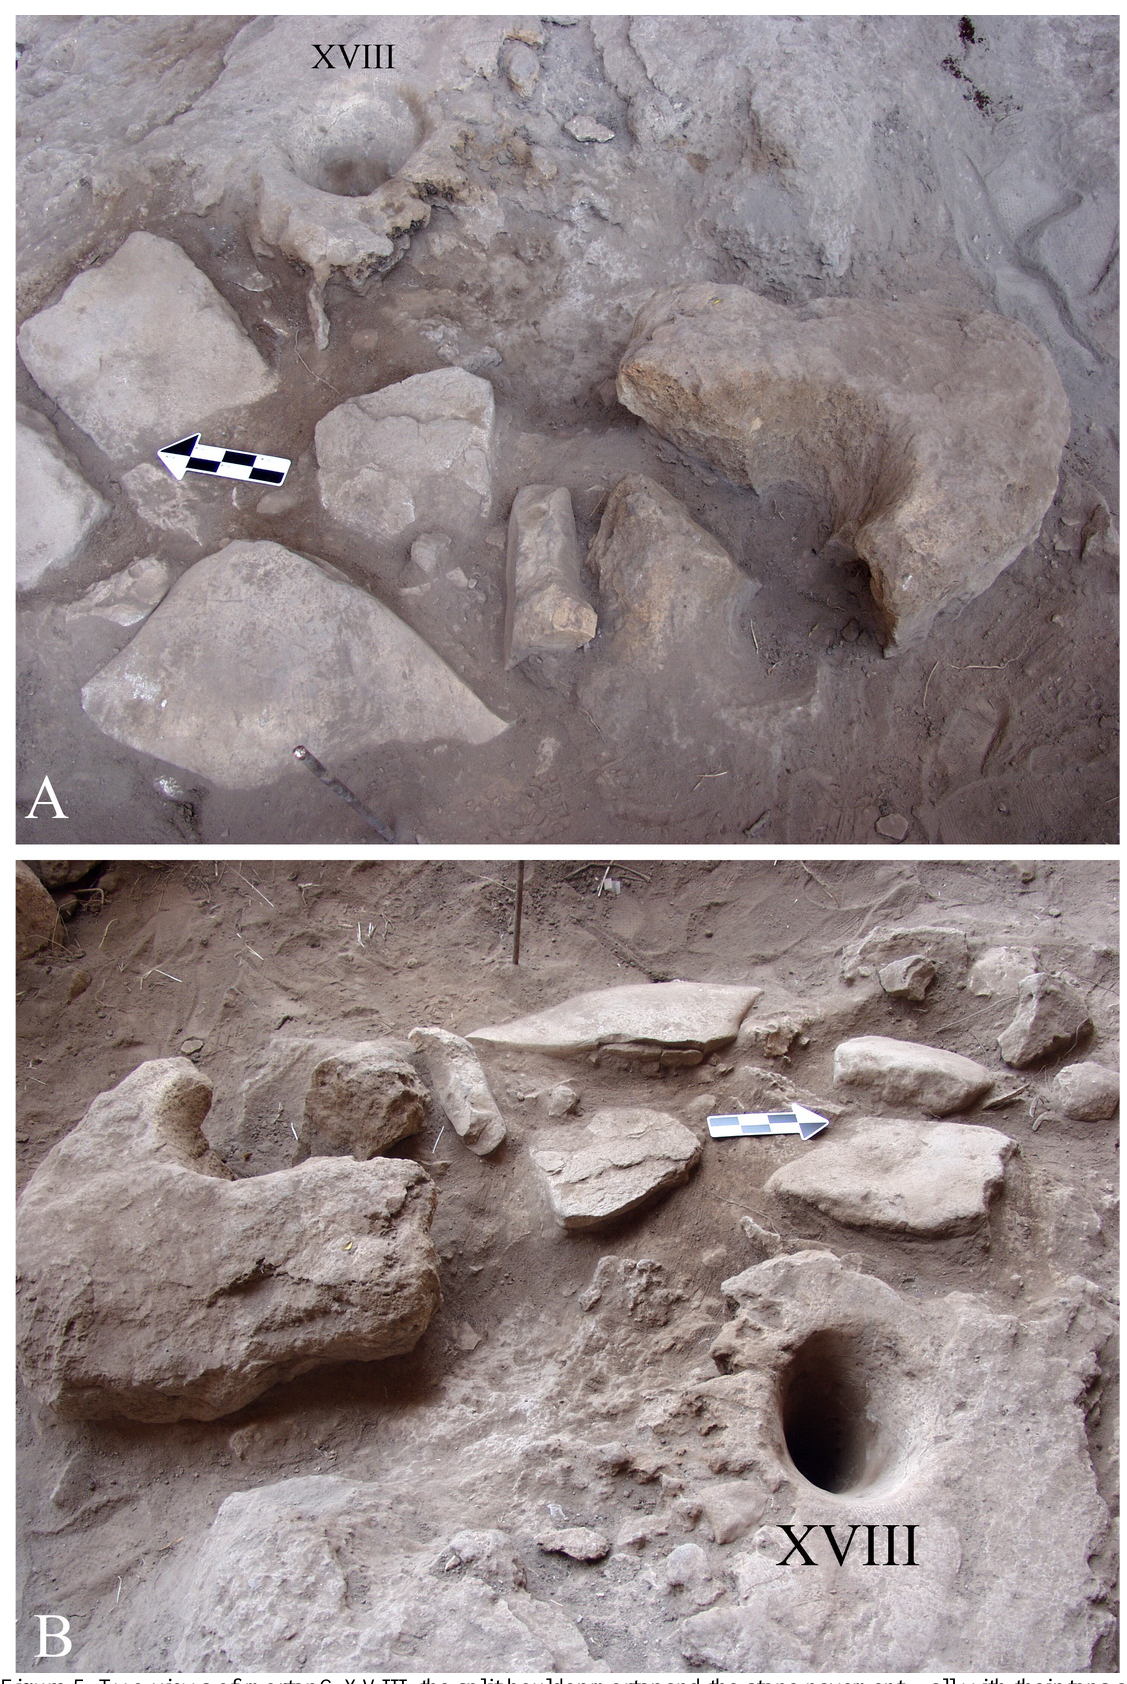
Figure 5. Two views of mortar C-XVIII, the split boulder mortar and the stone pavement – all with their tops at roughly the same level. Scale arrow 20